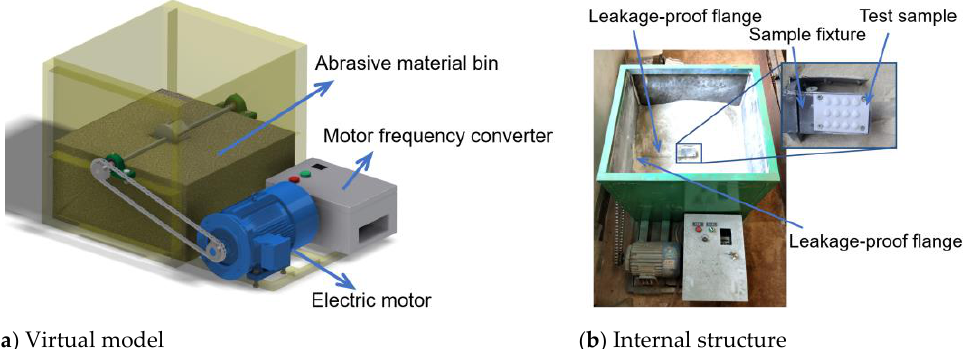
Figure 3. Abrasive wear testing